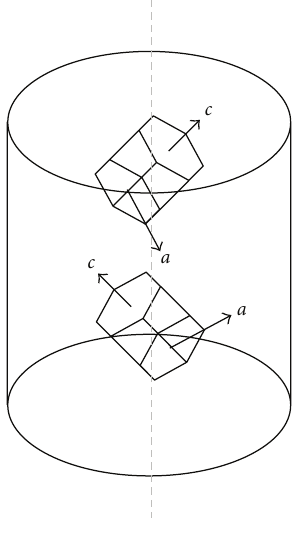
Figure 3: Schematic diagram showing textures of monolithic AZ31/AZ91 and AZ31/AZ91/TiC nanocomposite based on X-ray di ff raction. In each case, vertical axis (dotted line) is parallel to extrusion direction. Each cell is made up of 2 HCP units having 1 common (0 0 0 2) basal